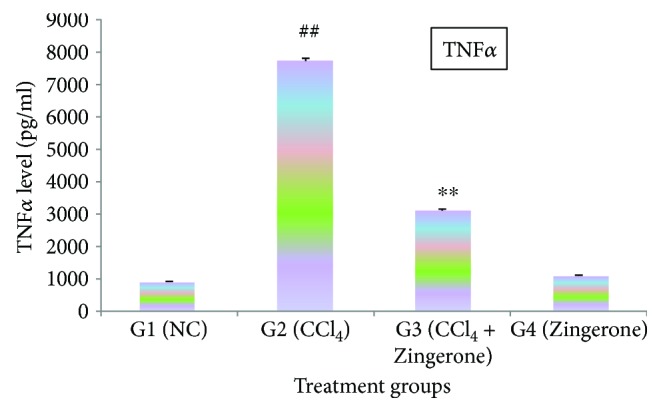
Effect of Zingerone on TNFα levels in the kidney tissue of CCl4-treated mice. ##p < 0.001 compared with NC group 1 and ∗∗p < 0.001 compared with CCl4-treated toxic group 2.